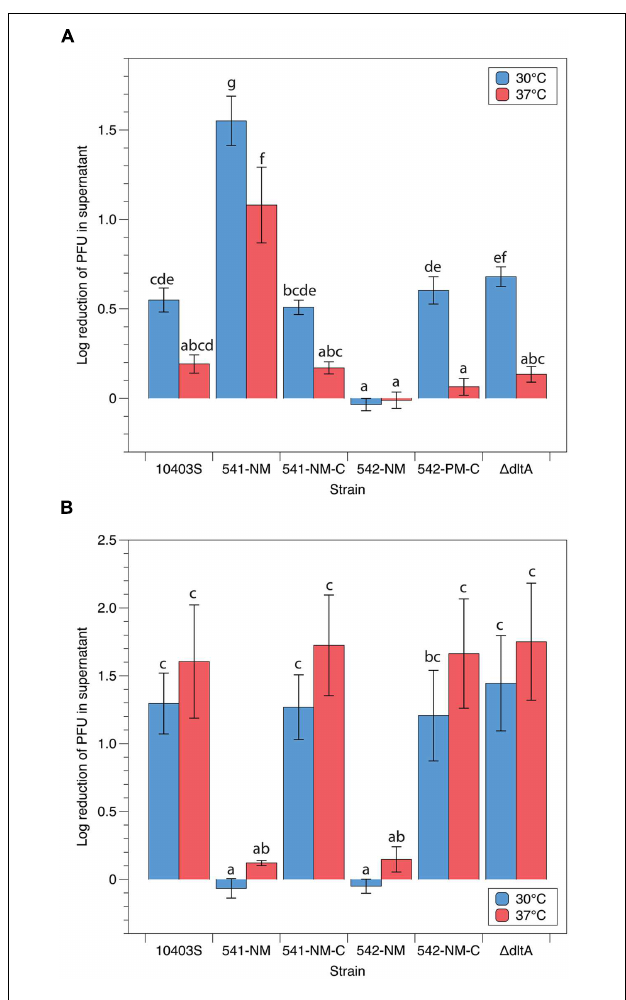
FIGURE 5 | Adsorption efficiencies of P100-like phages (A) LP-048 and (B) LP-125 on teichoic acid component mutants. Values shown are the log 10 reduction of free phage in the supernatant of each co-incubation between phage and host. The log 10 reduction is calculated by subtracting the log-transformed number of phage left in in the supernatant from the log-transformed number of phage in the negative control (BHI). We also tested the (cid:49) dltA strain complemented with the WT allele of dltA ; however, no significant differences from either the (cid:49) dltA strain or WT 10403S were observed. Lower values represent less efficient adsorption. Bars that do not share any letters represent values that are significantly different; for example, a bar marked with c, d, and e is significantly different from a bar marked with f. Three biological replicates were conducted. Error bars represent the standard